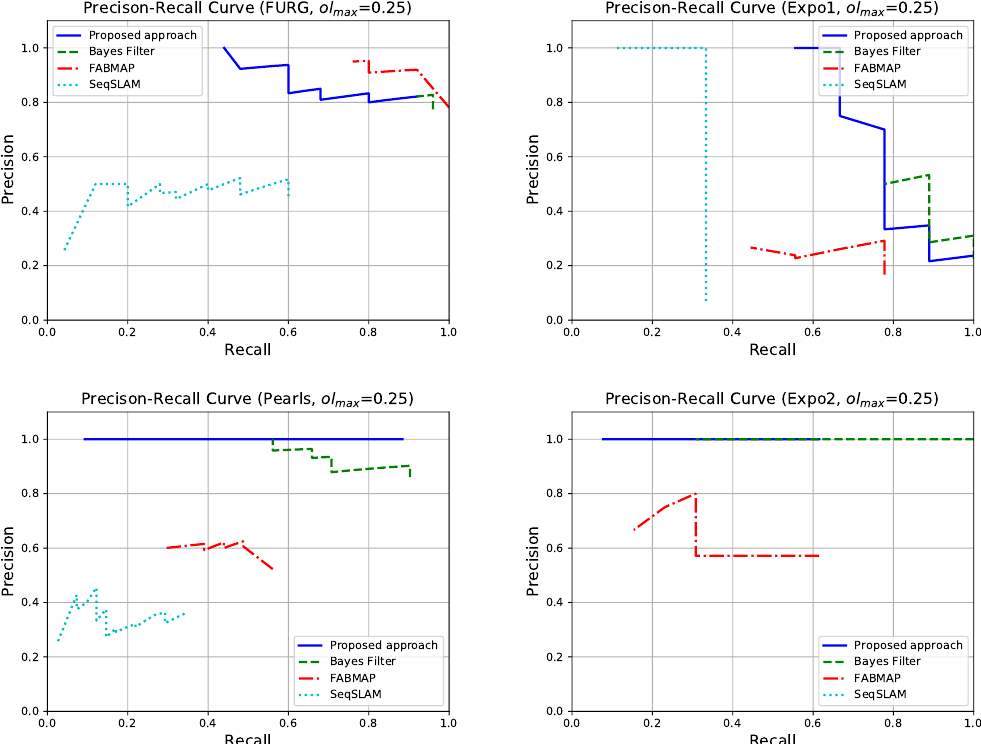
Figure 11. Precision-Recall curves obtained with ol max = 0.25. A method is not shown in a plot when it was not able to recognize previously seen